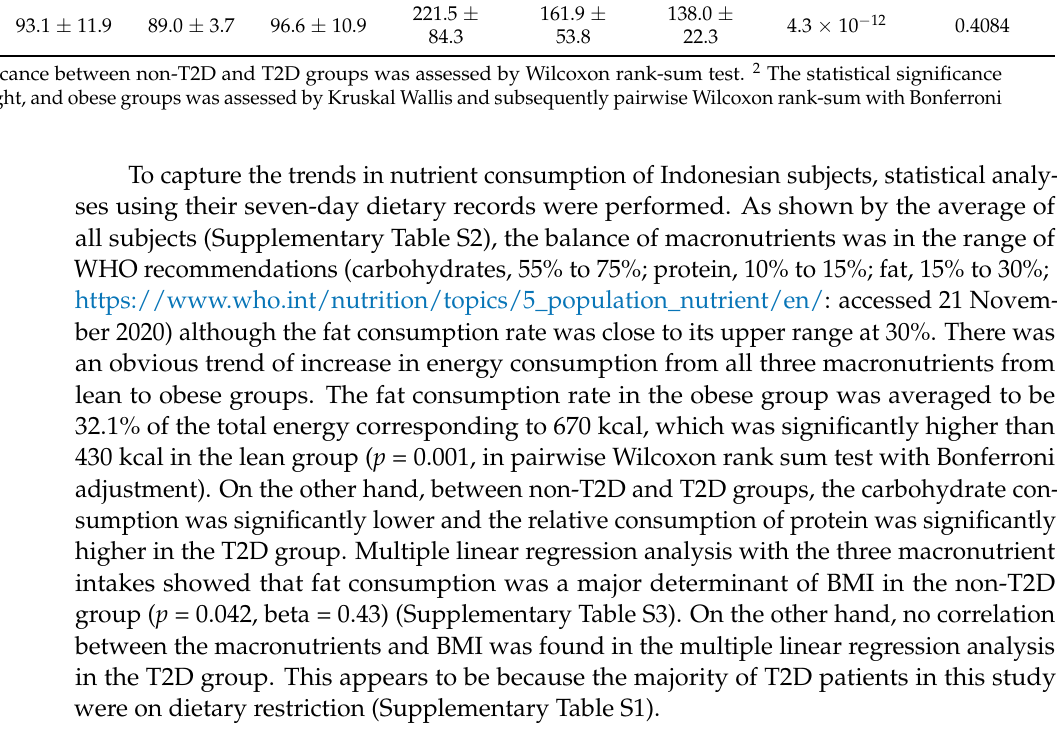
p Value 1 p Value 2